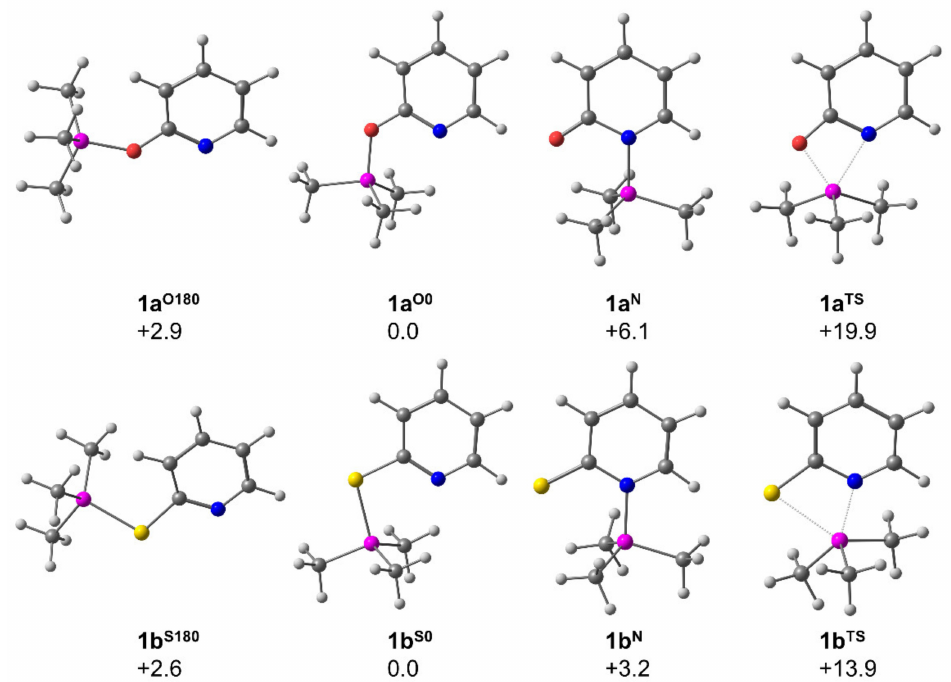
Figure 4. Relative Gibbs free energy values (in kcal · mol − 1 ) computed at the PBE0 D3BJ ZORA-def2- TZVPP level of theory for isomers of 1a and 1b . The superscript indices (from left to right) indicate the isomer/conformer with Si-X bond and ca. 180 degree torsion about Si-X-C-N ( X180 ), with Si-X bond and ca. 0 degree torsion about Si-X-C-N ( X0 ), with Si-N bond ( N ), and the transition state ( TS ) for the interconversion of isomers X0 and N into one another (cf. Figures S19–S26 and Tables S1–S8 in the supporting